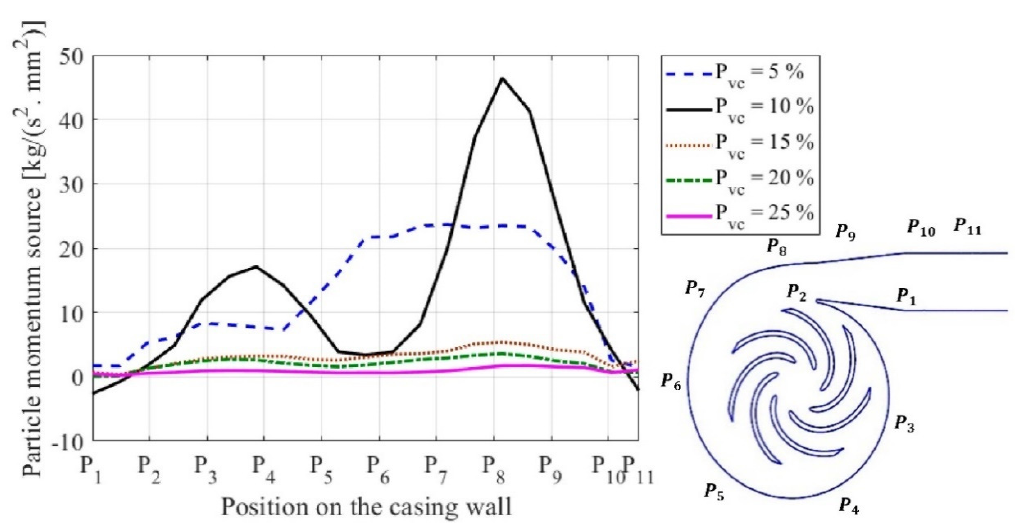
Figure 10. Variation of particles momentum source along the casing wall with different values volumetric concentration of the solid particles.